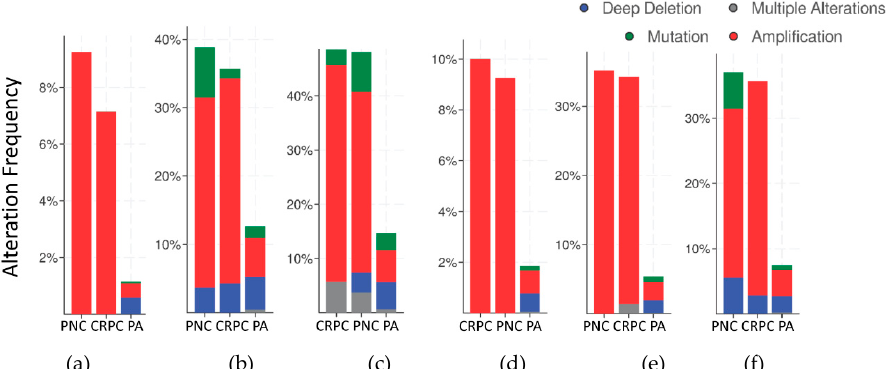
Figure 3. Copy number alteration frequency of HMGB1, HMGB2, and their targets in prostate cancer: ( a ) HMGB1, ( b ) HMGB1 interactome targets from PC-3 library, ( c ) HMGB1 interactome targets from